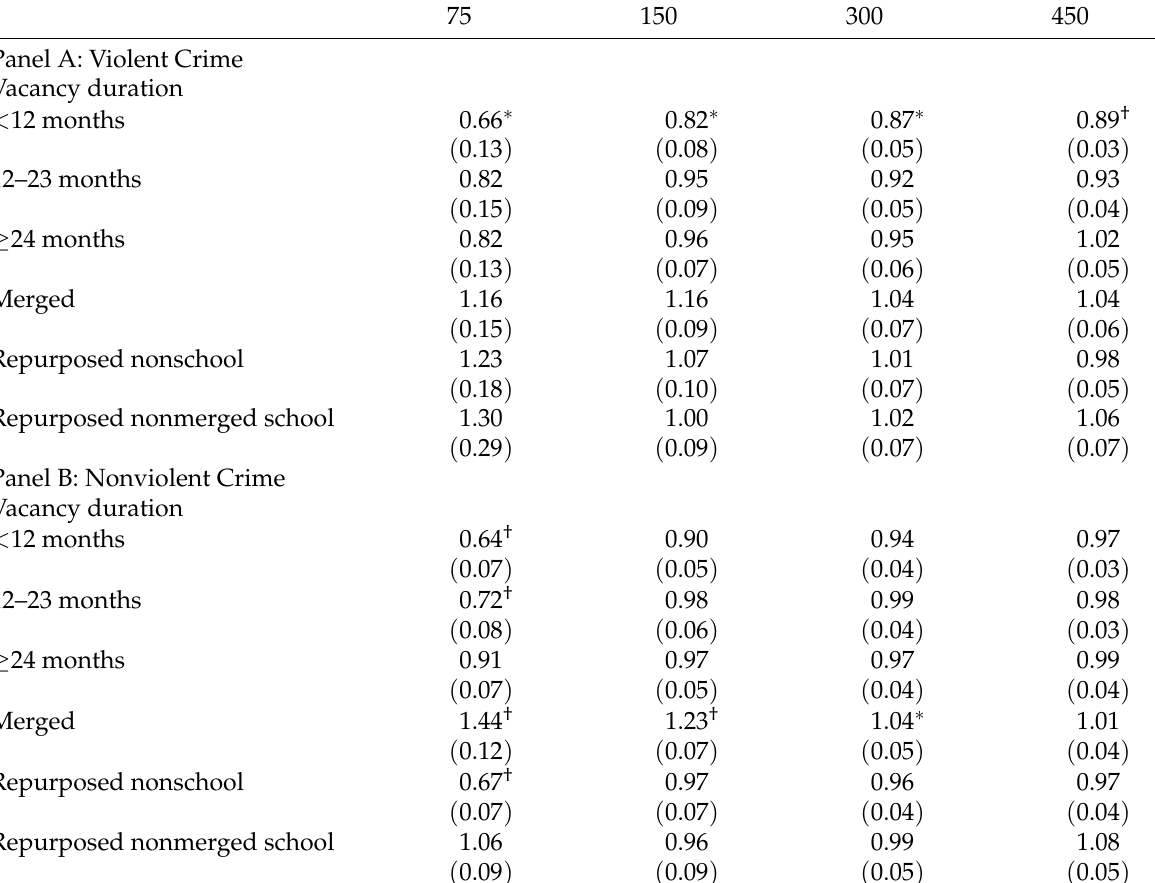
Table 4: Results from negative binomial regressions of violent and nonviolent crime counts on school closure condition by buffer radius and vacancy